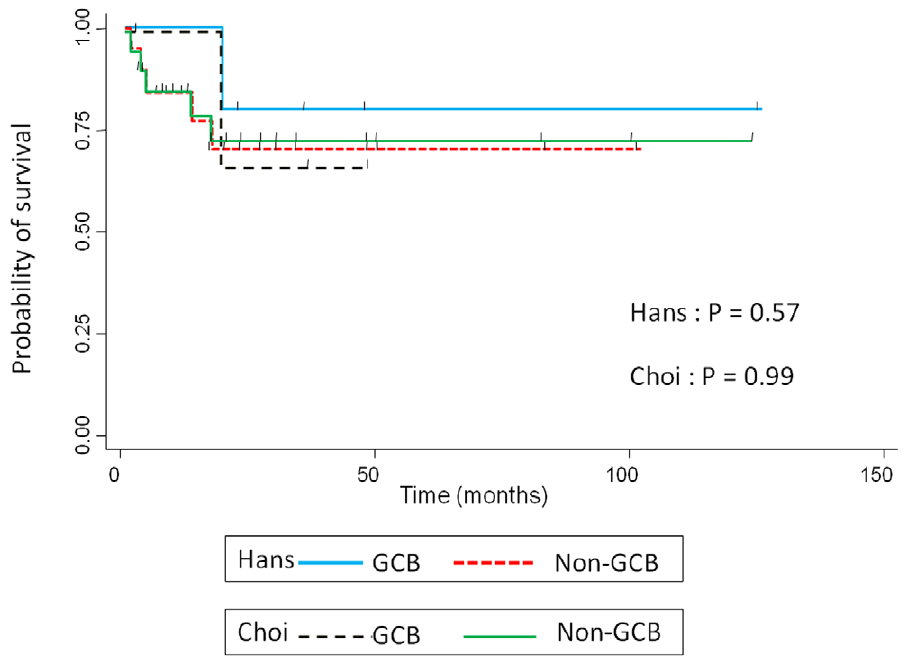
Figure 3. Kaplan–Meier plot showing overall survival for patients with localized nasal/paranasal DLBCL.